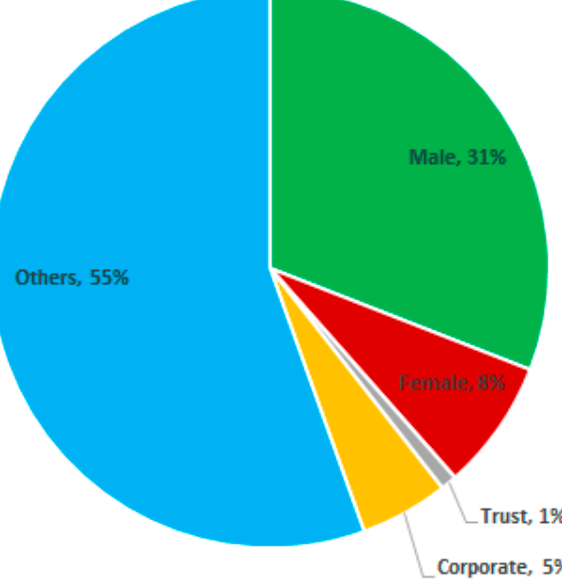
Figure 3. Percent of Non-Resident Security Holders by Investor Type and Gender. Source: SPX (2020a).